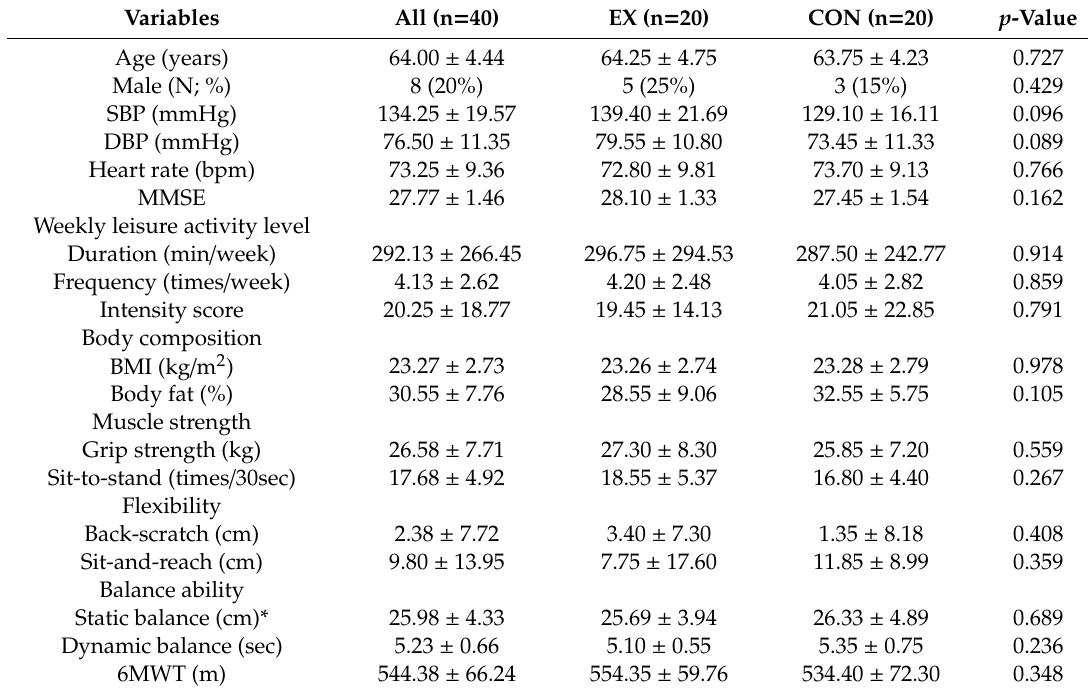
Table 1. Group comparison at